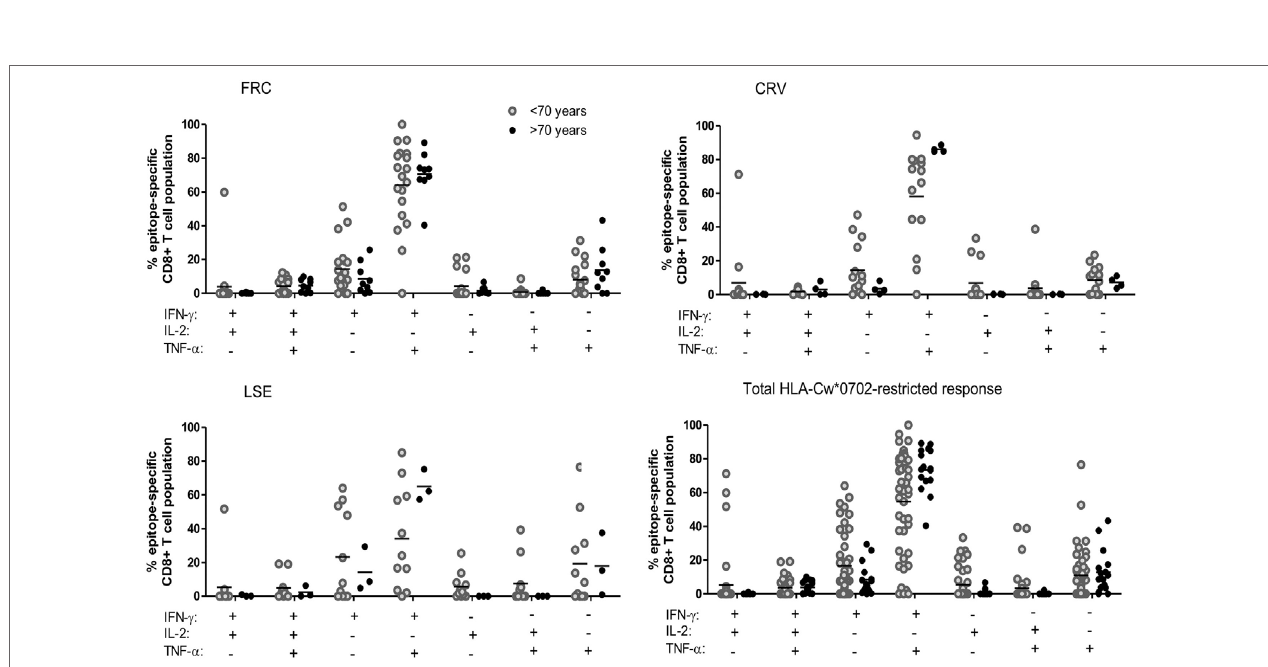
FigUre 3 | Memory inflation of HLA-Cw*0702-restricted T-cell responses is seen within individual donors. (a) Example of memory inflation within donors. FRC-specific CD8 + T-cell responses were followed within nine donors using blood samples taken between 1 and 10 years apart. This figure shows the TNF- α response in three donors at the initial and final time points. Percentages represent the TNF- α response to peptide as a proportion of the total CD8 + T-cell repertoire. The same number of lymphocytes is demonstrated in the two representative plots at each time point per donor. [Additional time points are provided in panel (c) .] (b) Summary of longitudinal analyses of peptide-specific CD8 + T-cell responses. The initial and last time points (after 1–10 years) for each HLA-Cw*0702- restricted CD8 + T-cell response are shown for all nine donors. Statistical significance was determined by a paired Wilcoxon test. (c) Representation of all prospective peptide-specific T-cell responses at individual time points within each